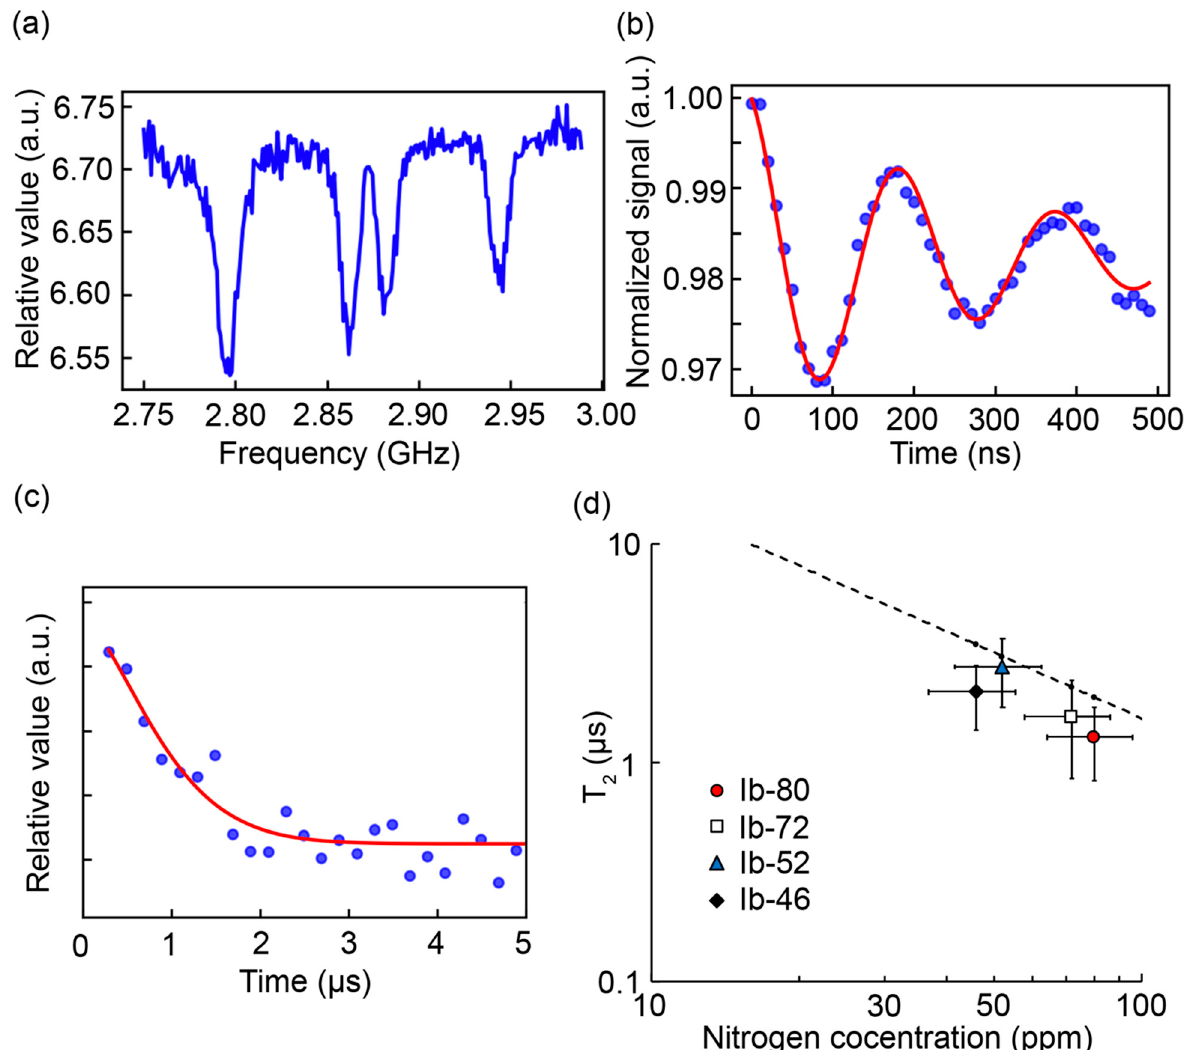
Figure 5. Evaluation of spin coherence time ( T 2 ) of NV − center in type-Ib diamond. (Sample: Ib-72 at fluence of 8 × 10 18 e/cm 2 for ( a – c )). ( a ) CW-ODMR spectra. ( b ) Rabi oscillation and fitting by damped sine curve. ( c ) Spin echo decay with free precession time and fitting by stretched exponential decay. ( d ) Dependence of nitrogen concentration on T 2 (Double logarithmic plot). Ib-80 (closed red circle), Ib-72 (open black circle), Ib-52 (closed blue circle), Ib-46 (closed black circle), respectively. Broken line shows Equation (1) [23].